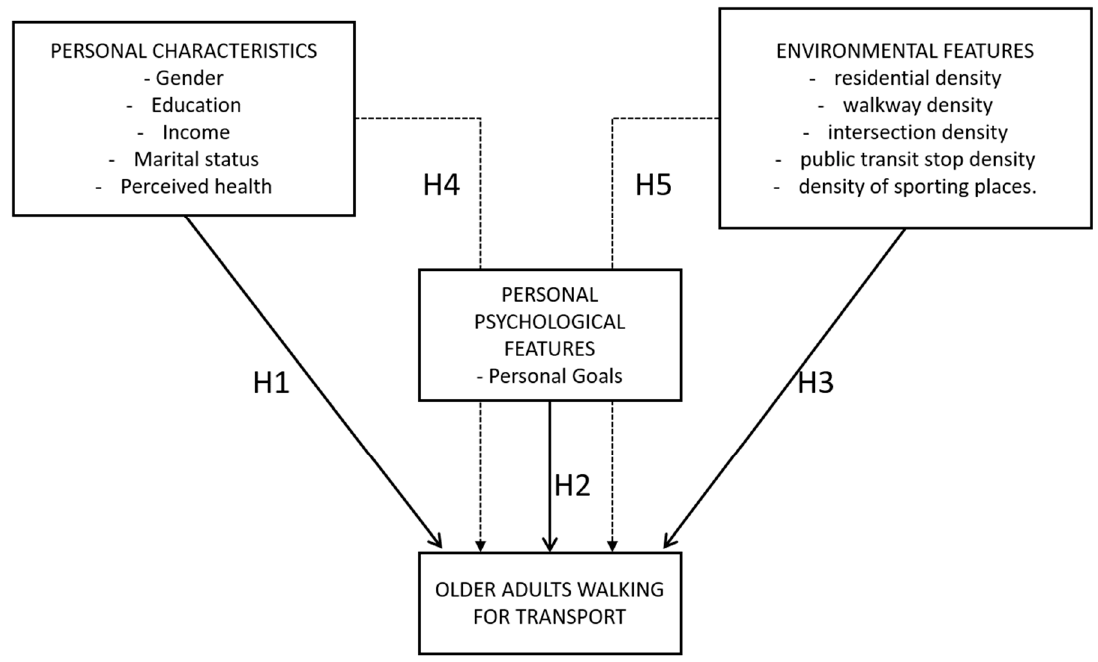
Figure 3. The conceptual framework.